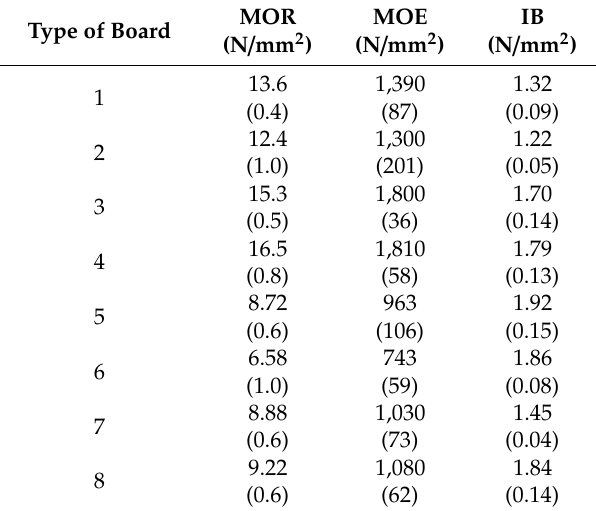
Table 6. Mean values of mechanical properties.